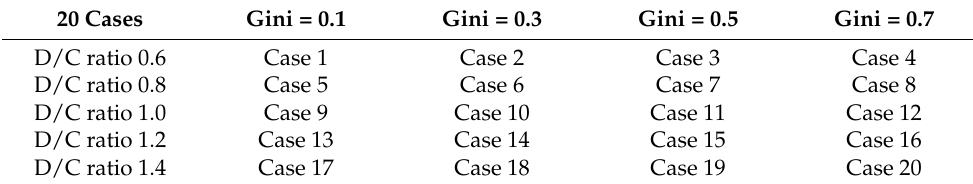
Table 2. Different simulation scenarios. As the Gini coefficient increases, the injury distribution becomes more unbalanced. As the D/C ratio increases, the demand increases, and the transport capacity decreases. Four transport methods were simulated for each